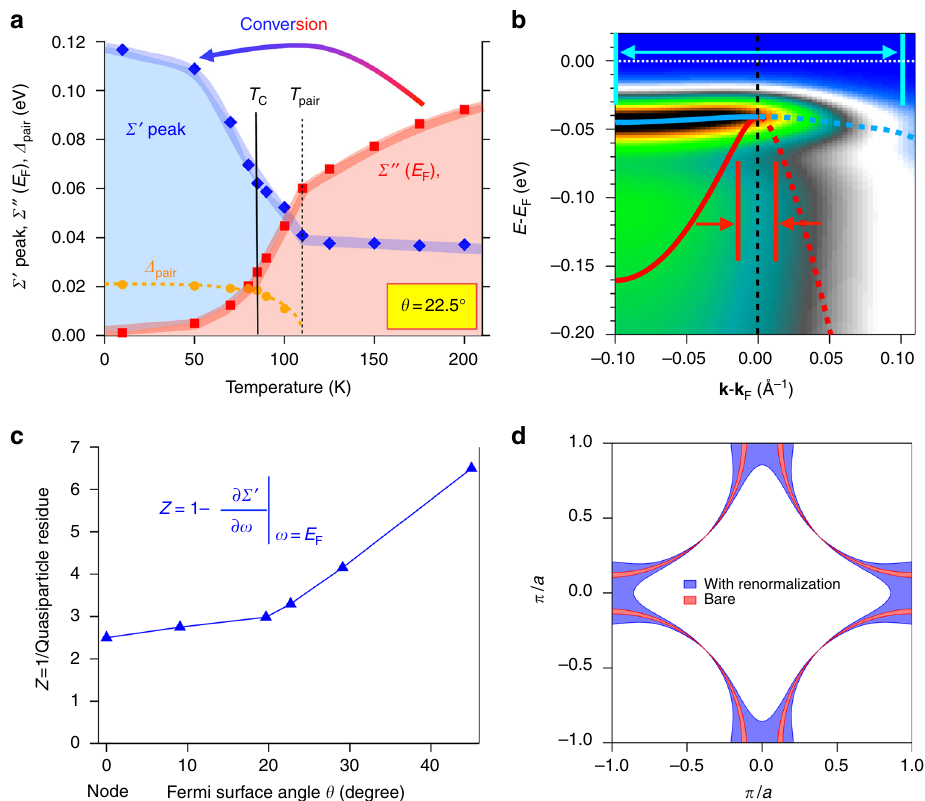
Fig. 3 More details of the effects of the self-energies. a Temperature dependence of gaps and self-energies of the θ = 22.5° mid-zone cut of Fig. 1. Parameters shown are Σ ′ peak (blue diamonds − Σ ′ value along the dashed line in Fig. 1u), Σ ″ ( E F ) (red squares — zero frequency portion of Fig. 1t), and superconducting gaps (orange circles — extracted from 2D fi ts). Upon cooling from high temperature, the main evolution of the parameters begins at T pair and not at T C . b Reproduction of the right half of the spectrum of Fig. 2j (antinodal states, cut 5, T = 15 K), with the renormalized quasiparticle dispersion (blue curve), and the extracted bare-band dispersion with no self-energies (red curve) overlaid on the spectrum. The superconducting gap is 40 meV. The red (bare) and blue (with renormalization) arrows indicate the effective range of k -states contributing to particle-hole mixing and pairing (see Supplementary Note 10). This effective k range is signi fi cantly larger for the renormalized band (blue) than for the bare band (red). c Quasiparticle renormalization factor Z (blue triangles) in the superconducting state as a function of Fermi surface angle, reaching the very large value of 6.5 at the antinode. d The effective k range for pairing in the Brillouin zone, where the effective k range with renormalization covers 11% Brillouin zone, the bare one only covers 2% Brillouin